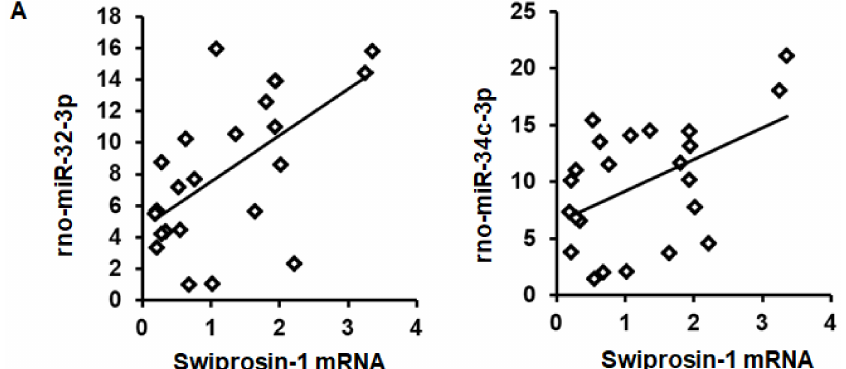
Figure 3. Expression of rno-miR-32-3p ( A ) and rno-miR-34c-3p ( B ) in the left ventricle from rats seven days after I / R. A). Box plots showing the level of expression and distribution of samples from sham surgery (Sham), ischemia / reperfusion (I / R), ischemic preconditioning (IPC), and ischemic postconditioning (IPoC). Data are analyzed by One-Way-ANOVA with Student–Newman–Keuls posthoc analysis (a; p < 0.05 vs. all other